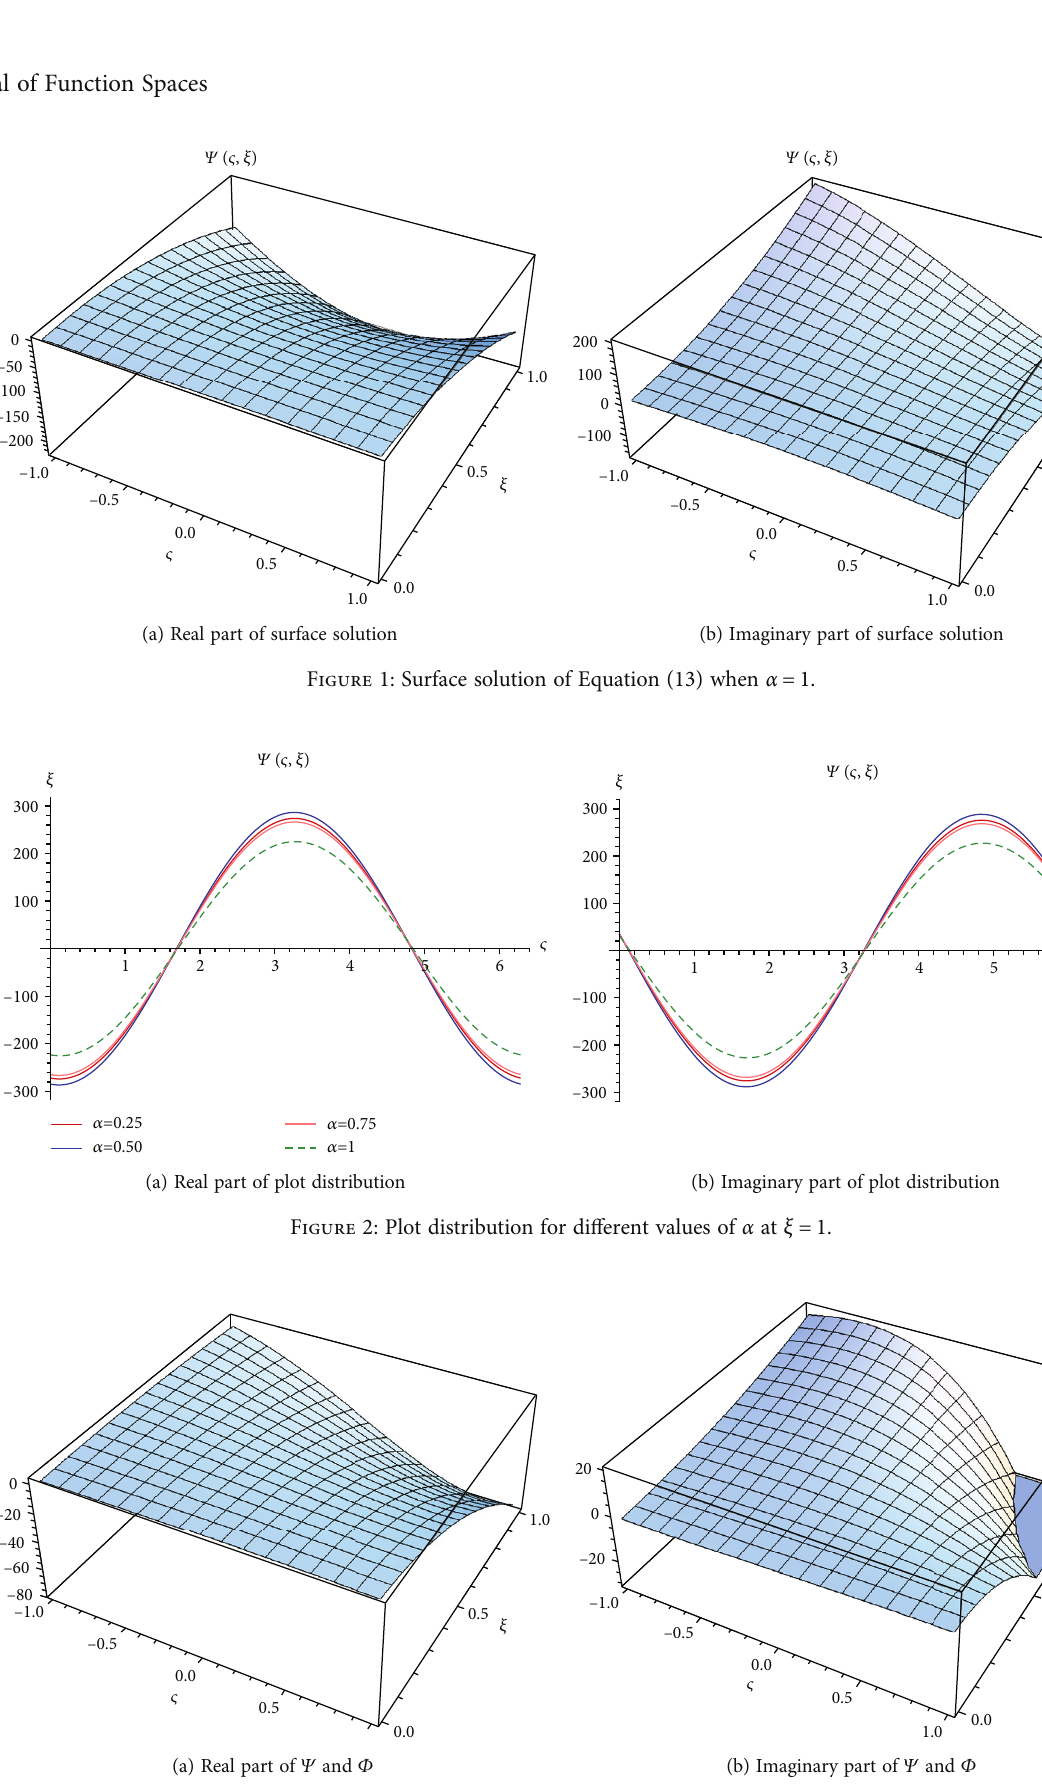
Figure 3: Surface solution of Equation (22) when α = 1